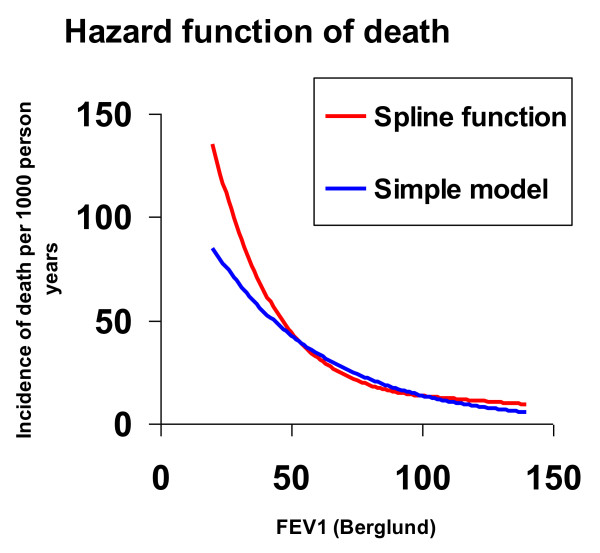
Hazard function of death, expressed as incidence of death per 1000 person years, by FEV1 percent predicted in a 70 year old man after two years observation time in a model using a spline function and a simple model.